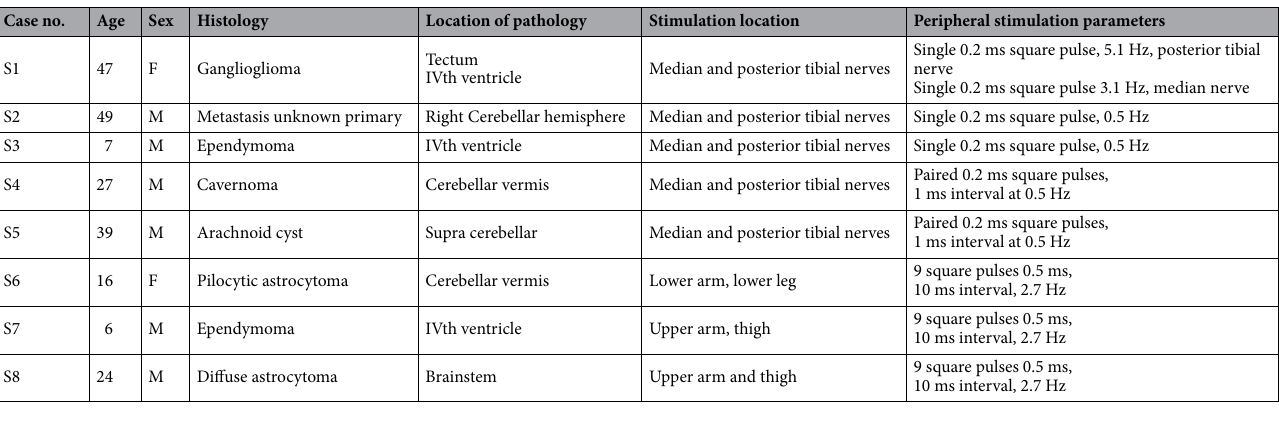
Table 1. The summary of recruited patient demographic and stimulation parameters for sensory mapping.